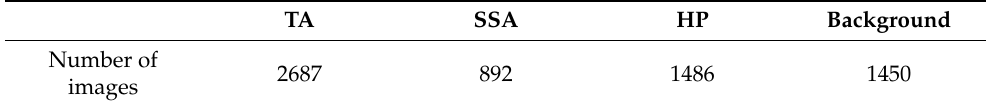
Table 1. The number of images in each polyp category of the